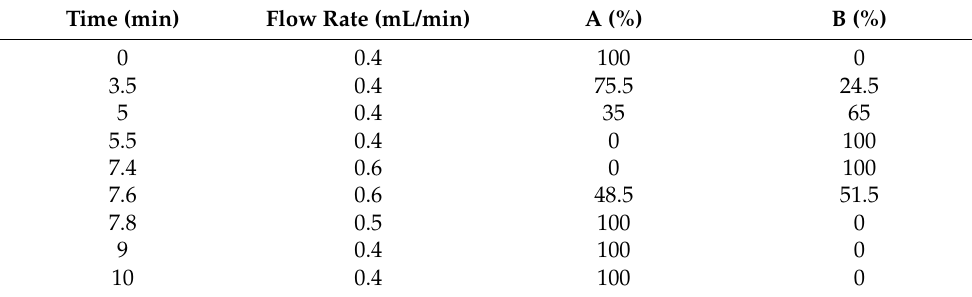
Table 3. The elution gradient of the mobile